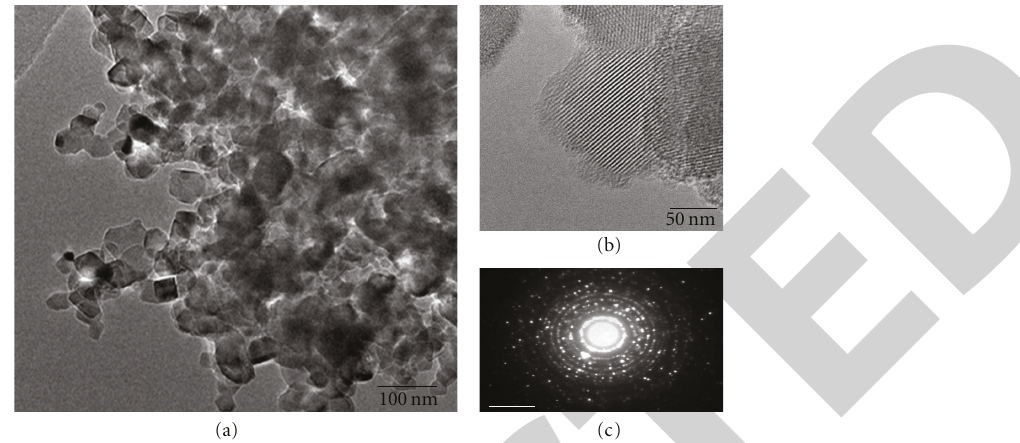
Figure 2: TEM images of 1.0 wt% La-doped TiO 2 (a) HR-TEM image (b) HR-TEM of the selective area, and (c) TEM image with electron di ff raction pattern.